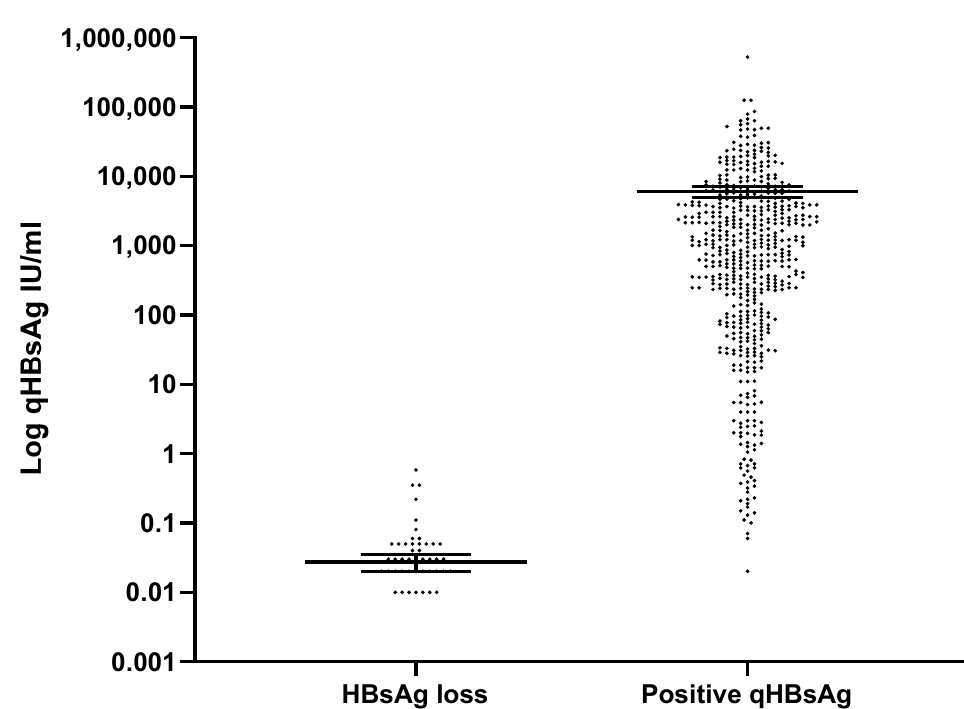
Figure 2. Quantitative HBsAg values in CHB patients who achieved HBsAg loss versus patients with positive HBsAg. HBsAg, hepatitis B surface antigen; IU, international units; qHBsAg, quantitative hepatitis B surface antigen.